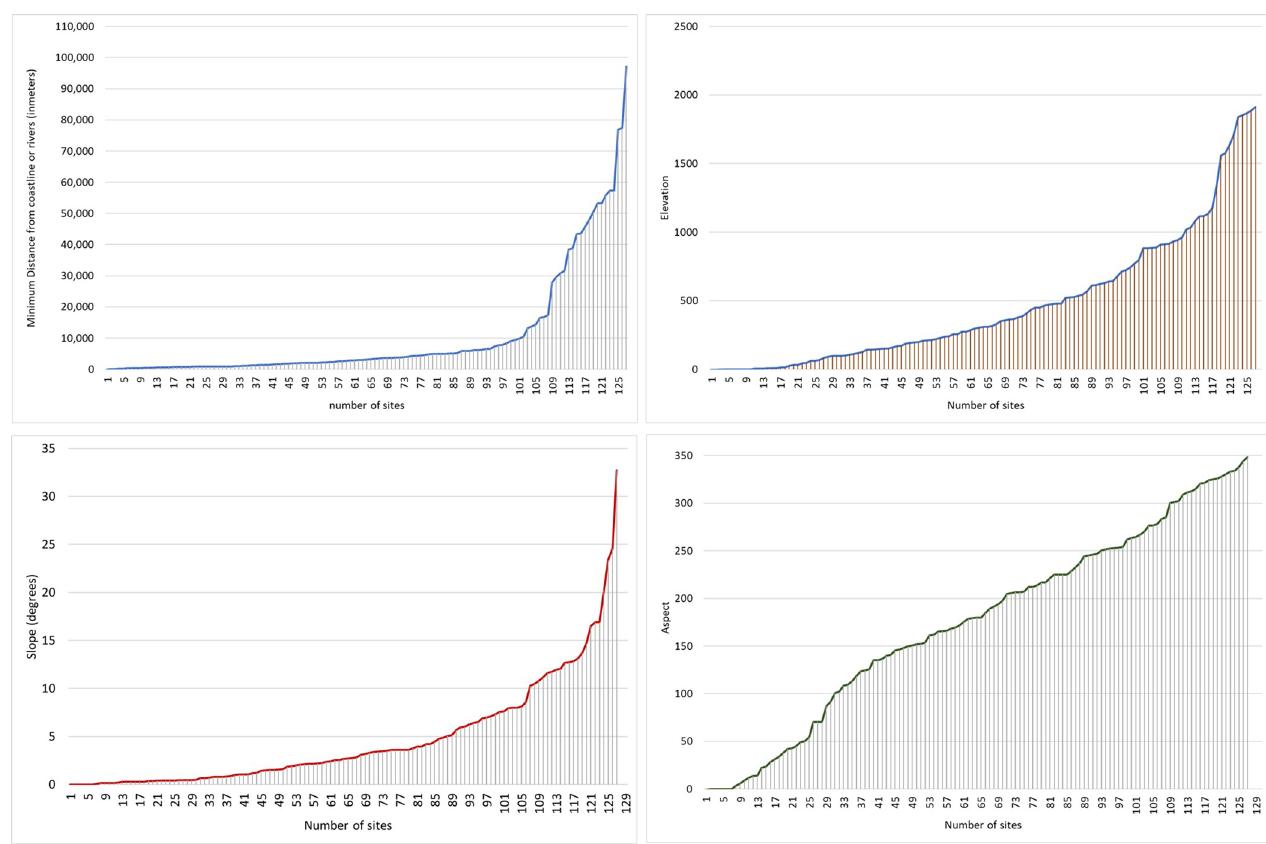
Fig 3. Main topographic patterns of Eastern Mediterranean Pleistocene archaeological sites. Graphs (a = distance from coast/rivers, b = elevation, c = slope, d = aspect) summarising the main topographic patterns of known Pleistocene archaeological sites across the Eastern Mediterranean.